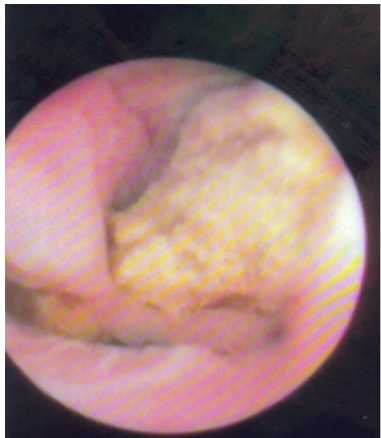
Figure 2 - Stone formation in implantation